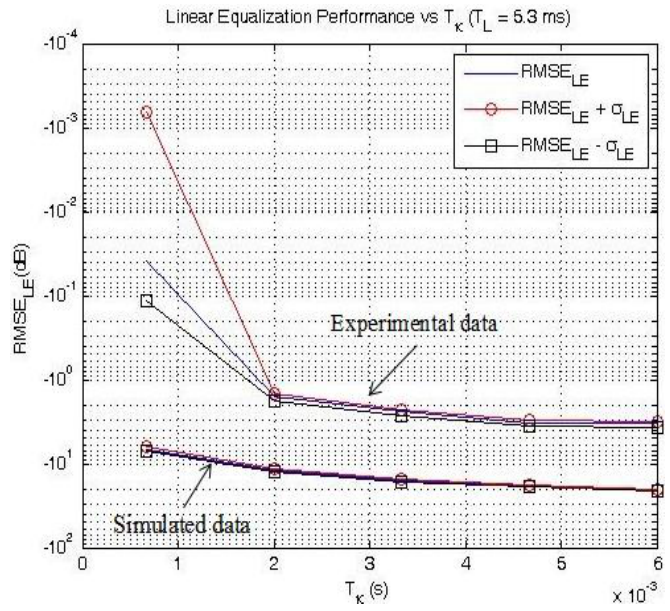
as a function of T MIMO_LE